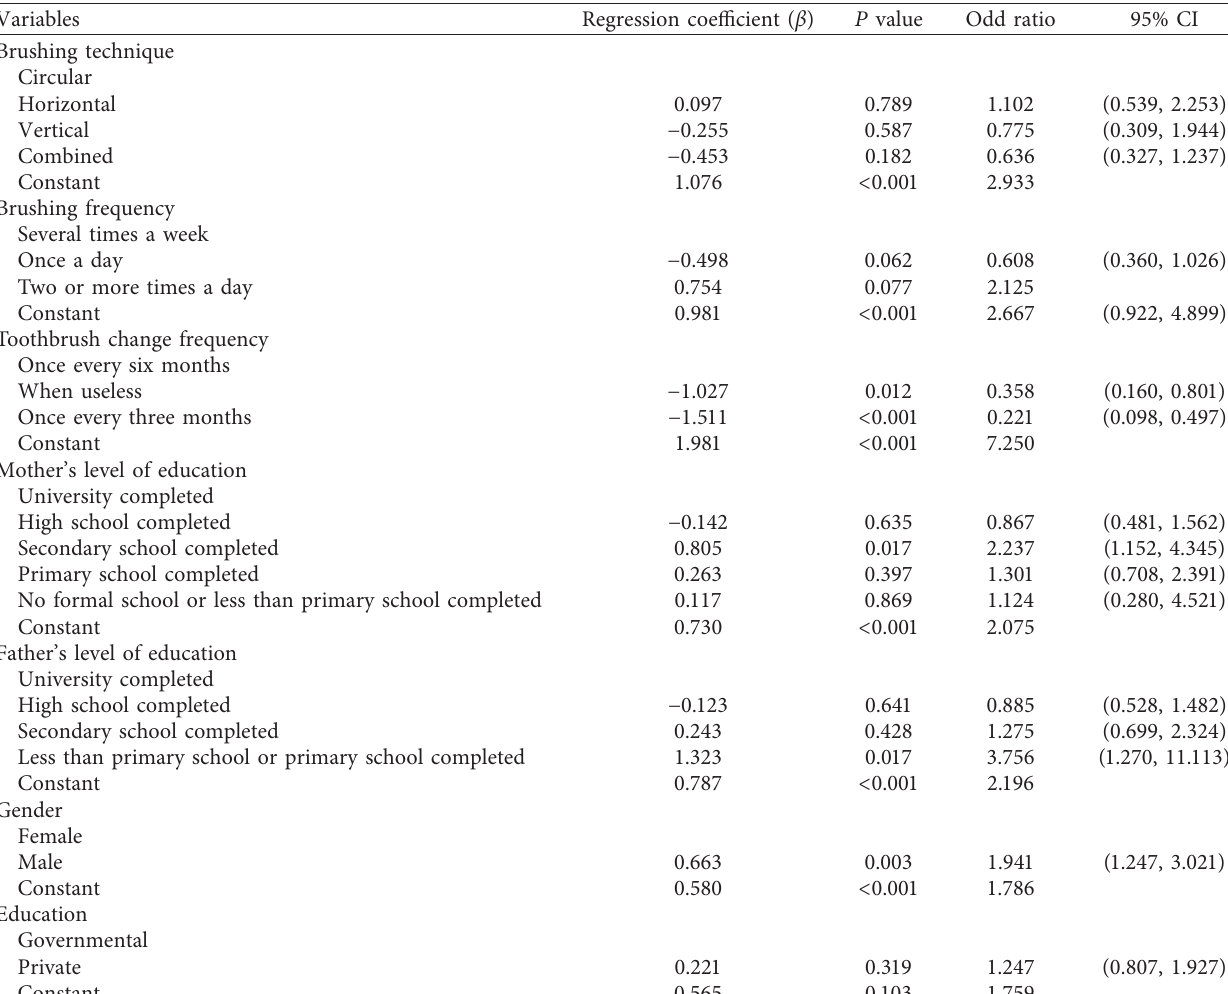
Table 4: Regression model of the association between brushing habits (brushing technique, brushing frequency, and toothbrush changing frequency), parents’ level of education, gender, education, and DMFT (decayed, missing, and